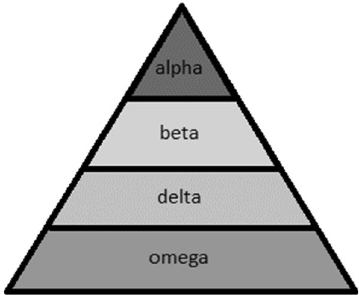
Fig. 4 Social Hierarchy of Grey